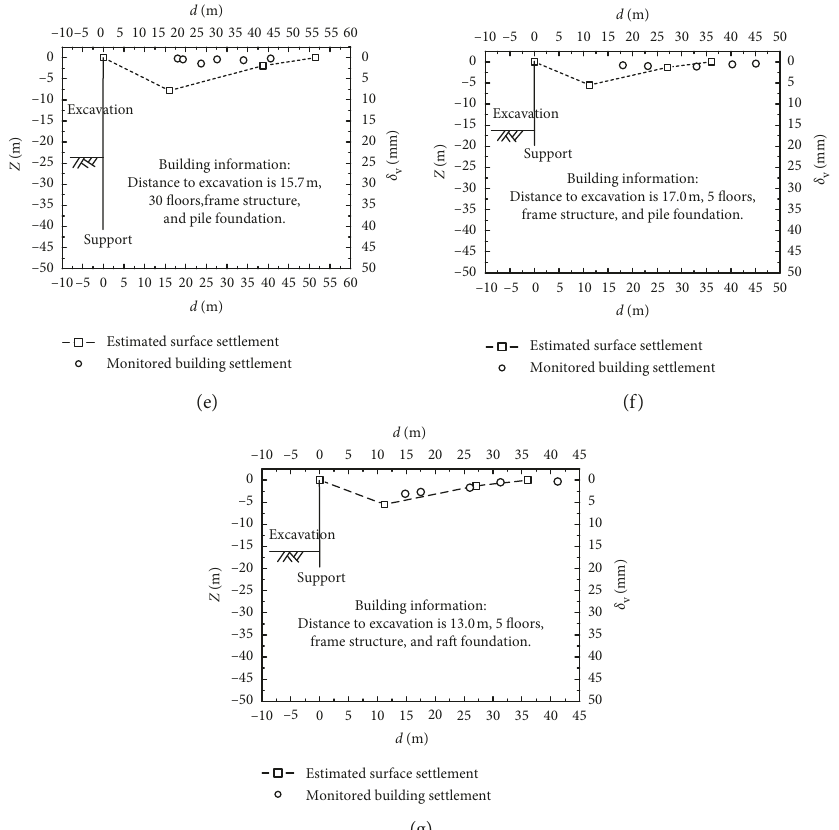
Figure 14: Building foundation settlements in zone C: (a) Xinzhuang Uptown Station: Building of Nanjing Forestry University; (b) Fenghuangshan Park Station: Commercial Building of Liuhe District; (c) Fenghuangshan Park Station: Residential Building of Water Conservancy Bureau of Liuhe District; (d) Fenghuangshan Park Station: Residential Building of No. 2 Nanjing Lock Factory; (e) Daxinggong Square Station: Chang’an International Building; (f) Longhua Road Station: Residential Building of Agricultural Bank; (g) Longhua Road Station: Dormitory of Tobacco